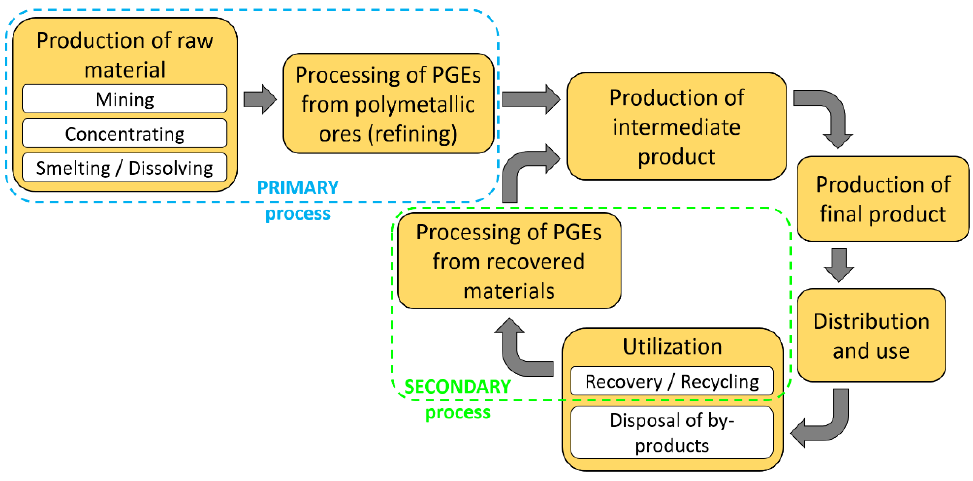
Figure 4. Lifecycle of PGEs: the primary and secondary processing [5,30,40,42,58].